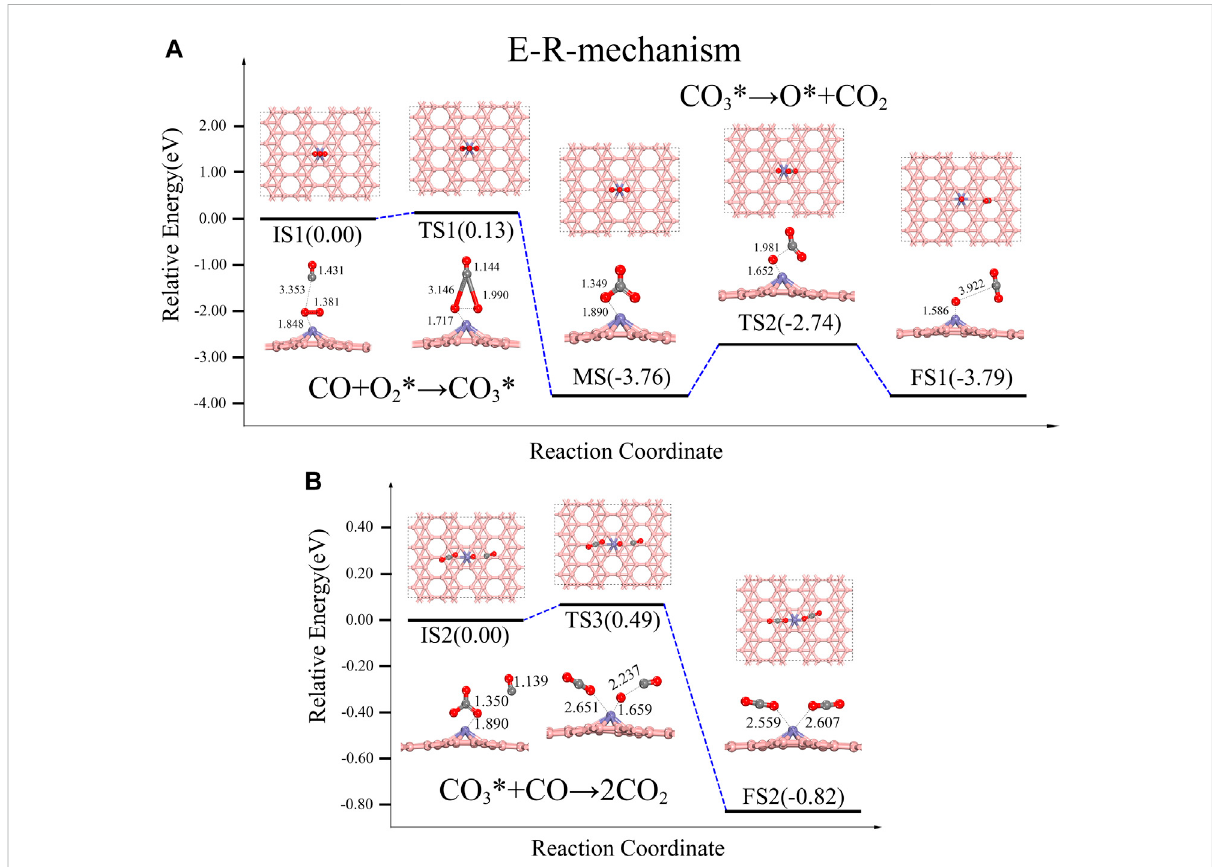
FIGURE 3 Energy distribution diagram under the E-R path and its corresponding structure diagram, the rate-determining step is IS2-FS2, turning over an energy barrier of 0.49 eV.